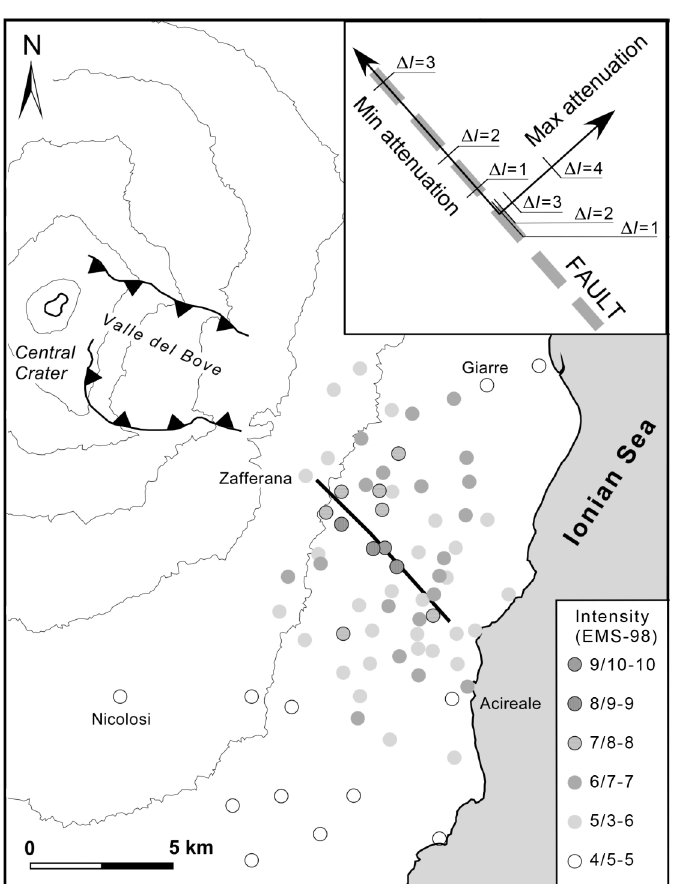
Fig. 9. Intensity map of the 1914 destructive earthquake ( I 0 = X EMS-98), from Azzaro et al. , (2000). Note the maximum intensities elongated astride the causative fault (line in bold), which corresponds to the minimum at- tenuation. Inset represents the minimum and maximum attenuation trends resulting from the curves of fig.